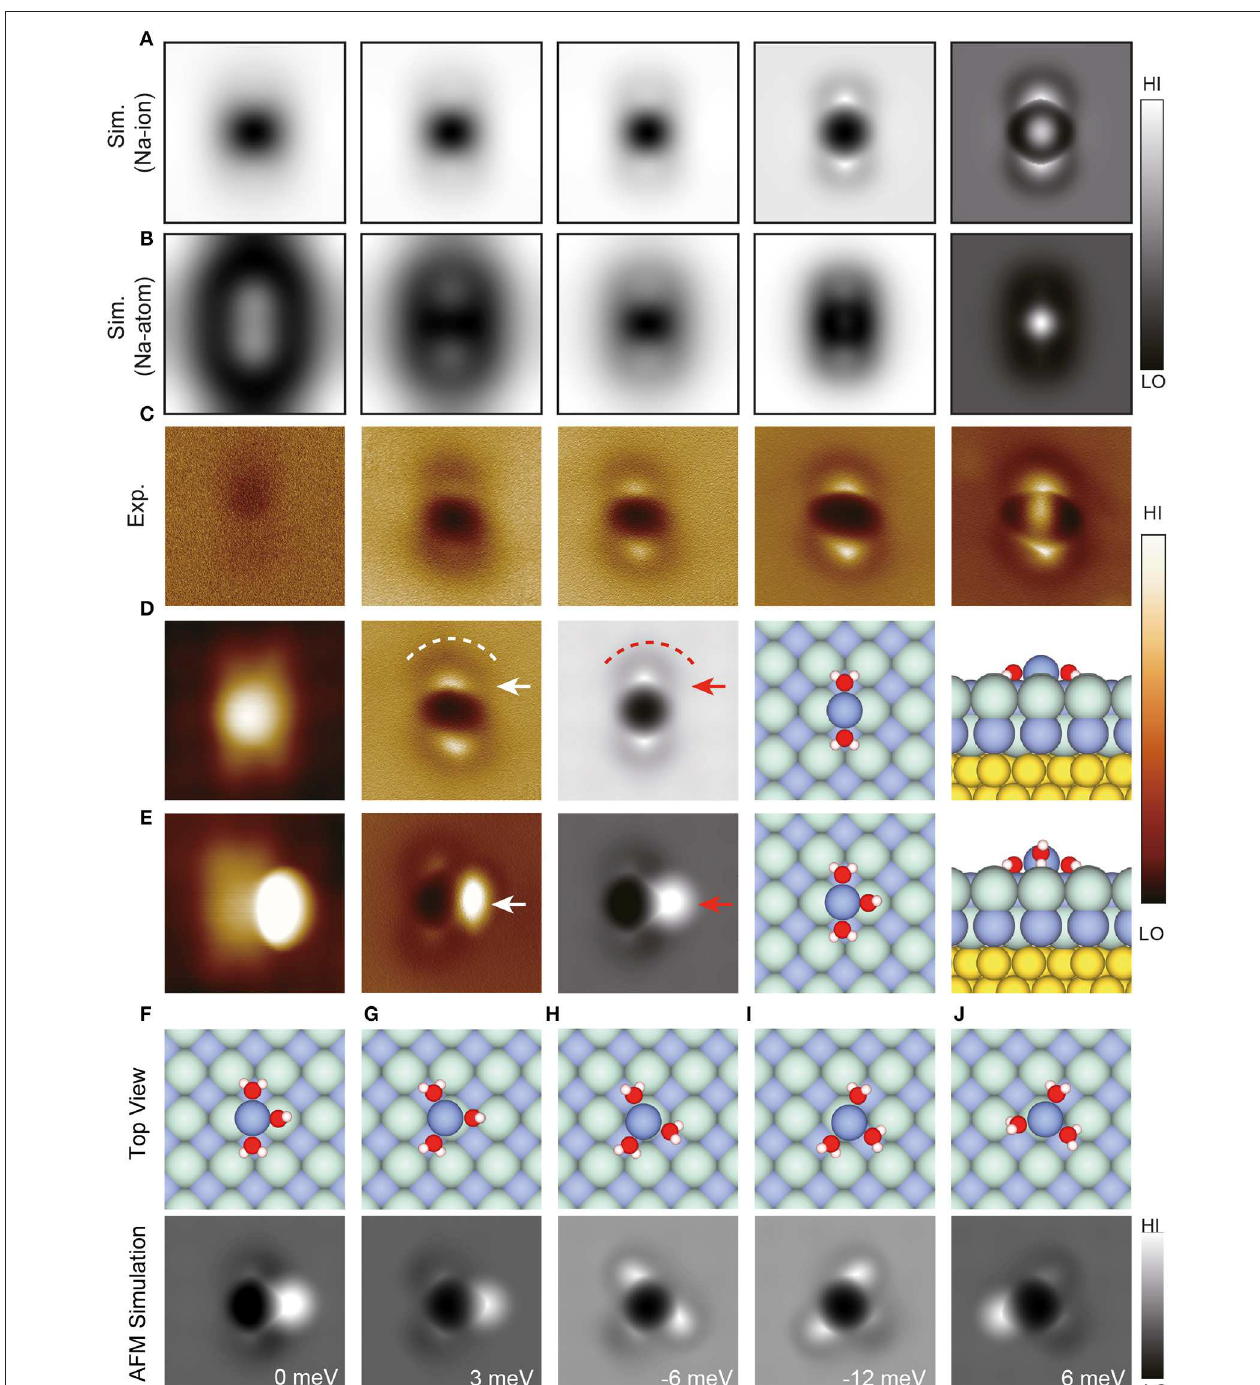
FIGURE 2 | Geometries and high-resolution STM/AFM images of Na + hydrates. (A,B) Simulated AFM images of Na + • 2H 2 O and Na • 2H 2 O, respectively. The tip heights of the simulated AFM images in (A,B) from left to right are 11 Å (13.05 Å), 10.05 Å (12.05 Å), 9.35 Å (10.65 Å), 8.05 Å (9.15 Å), and 7.5 Å (8.7 Å), respectively. These images were chosen to show the typical feature change as the tip height decreased. (C) Experimental 1 f images of Na + • 2D 2 O recorded at the tip heights of 220, 150, 100, 50, − 10 pm, respectively. (D,E) The STM/AFM images (acquired with a CO-tip), AFM simulations and atomic models (left: top view; right: side view) of Na + • nD 2 O clusters ( n = 2–3), respectively. (F–J) Atomic models (top view) and simulated AFM images of different types of Na + • 3H 2 O. The relative energy of different Na + • 3H 2 O with respect to the total energy of the structure in (E) was labeled at the bottom right of simulated AFM images. The white (red) arrows in